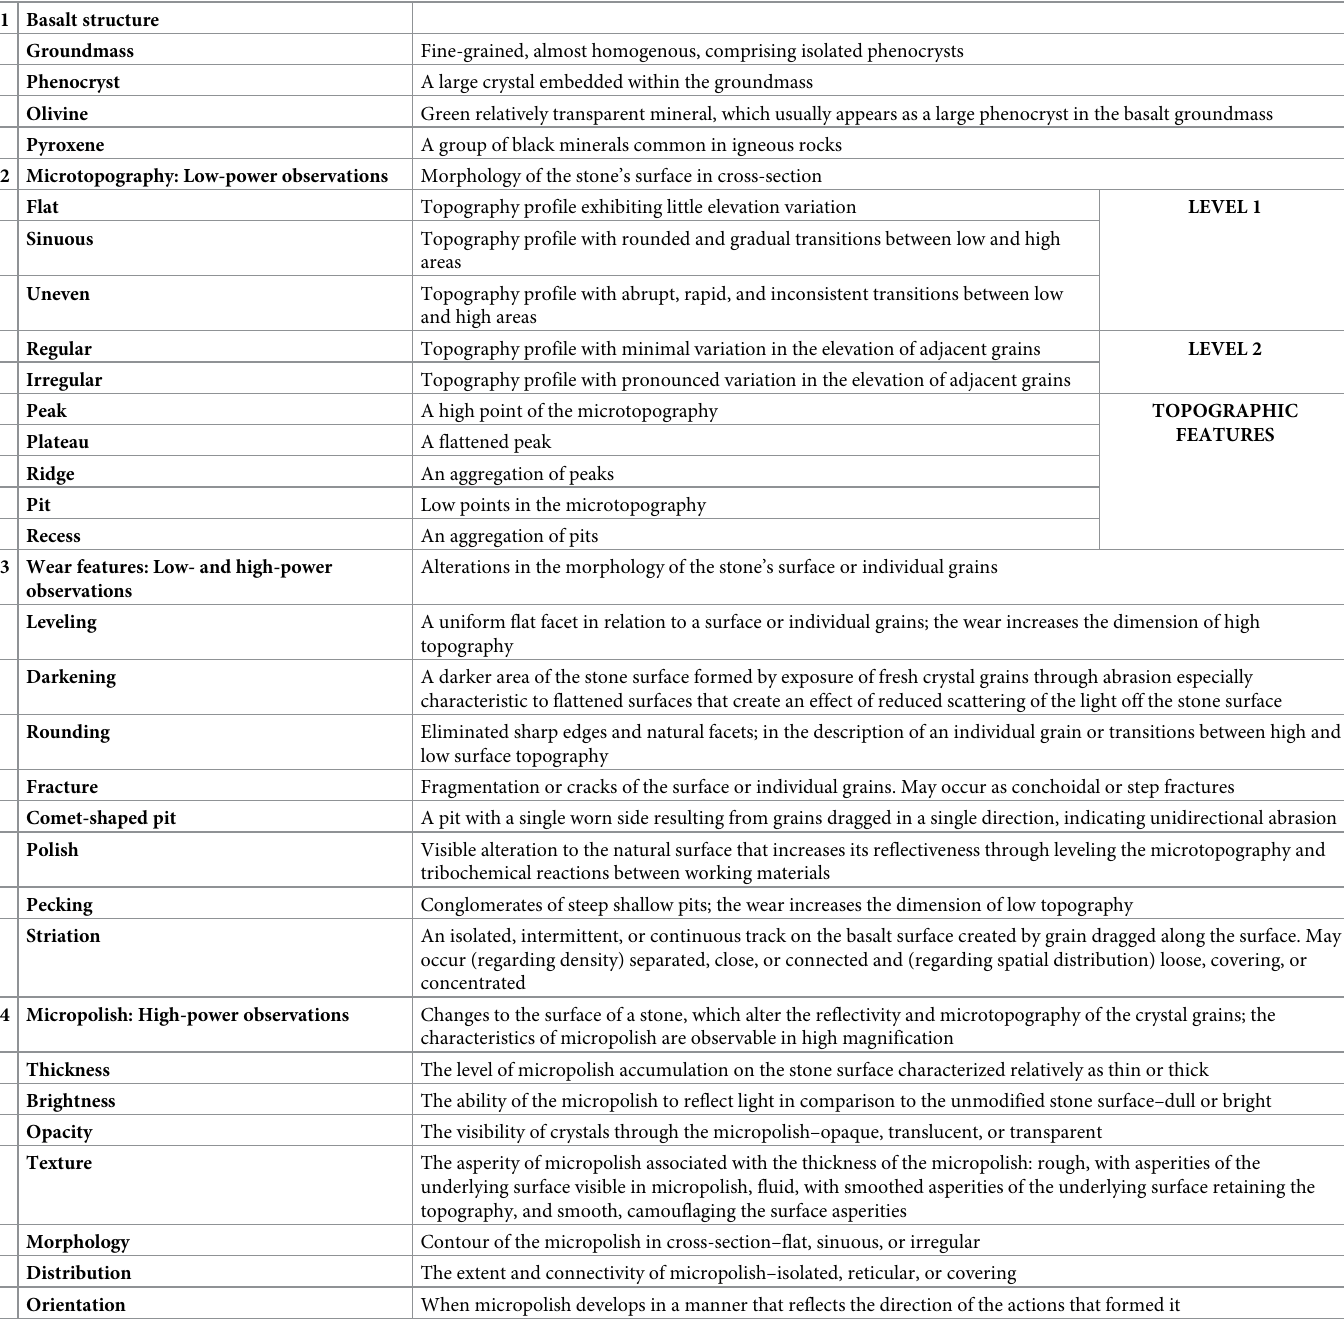
Table 1. Attributes used to characterize the wear observed on the archaeological vessels and the experimental pieces [based on 88, 103, 104,